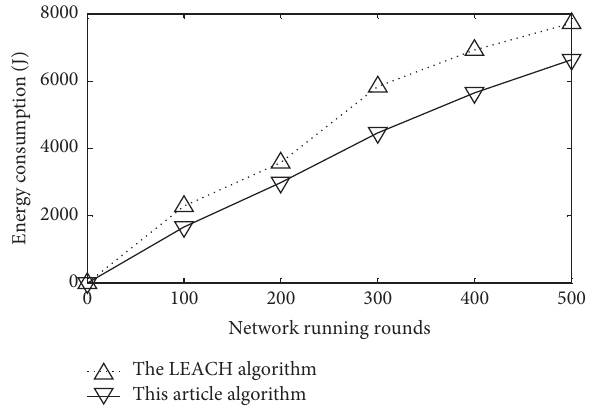
Figure 4: Energy consumption comparison in this article’s algo- rithm and the LEACH algorithm under different network running rounds (when s � 0.15).